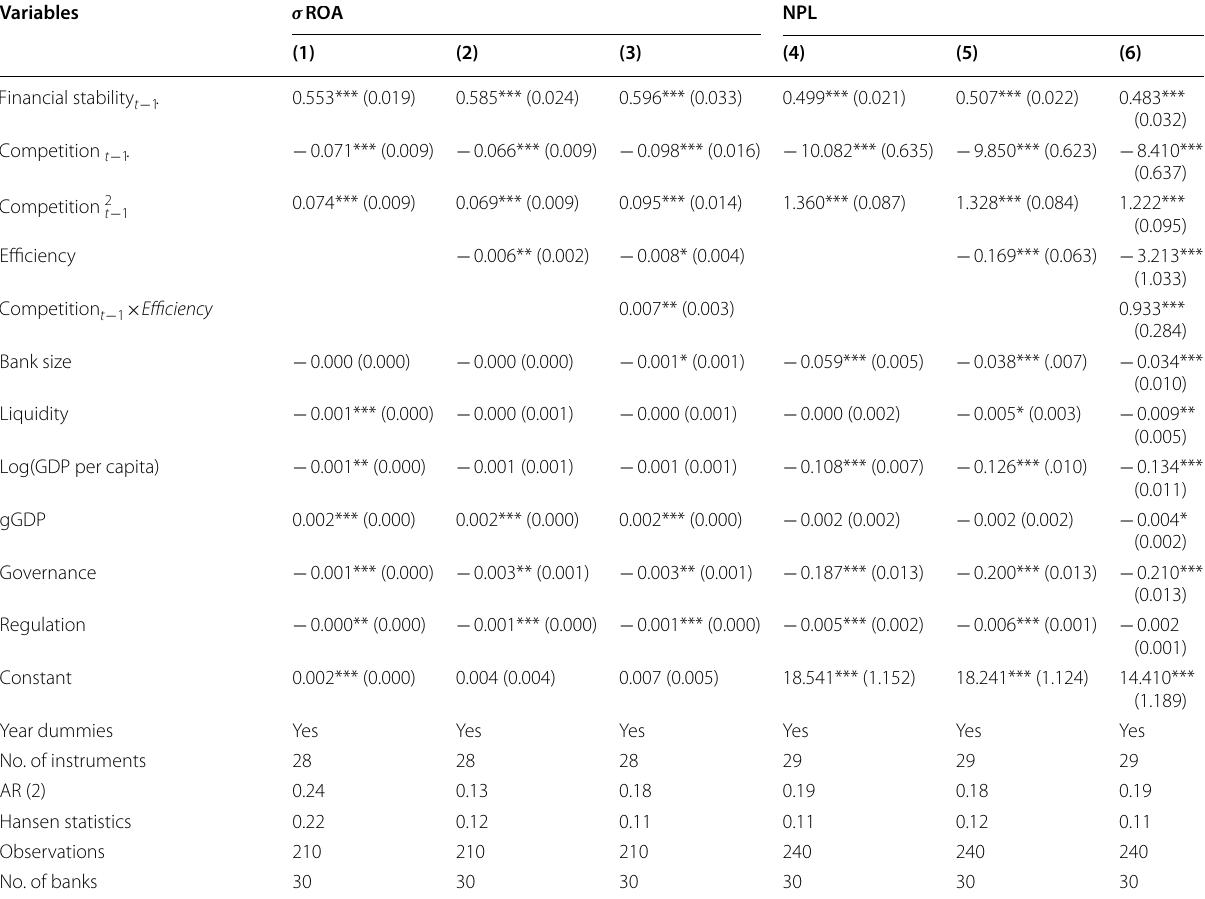
Table 4 Robustness check using alternative measure of financial